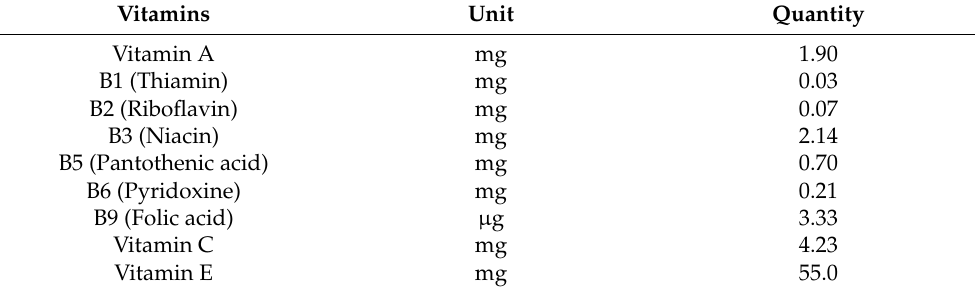
Table 3. Vitamins in NCS